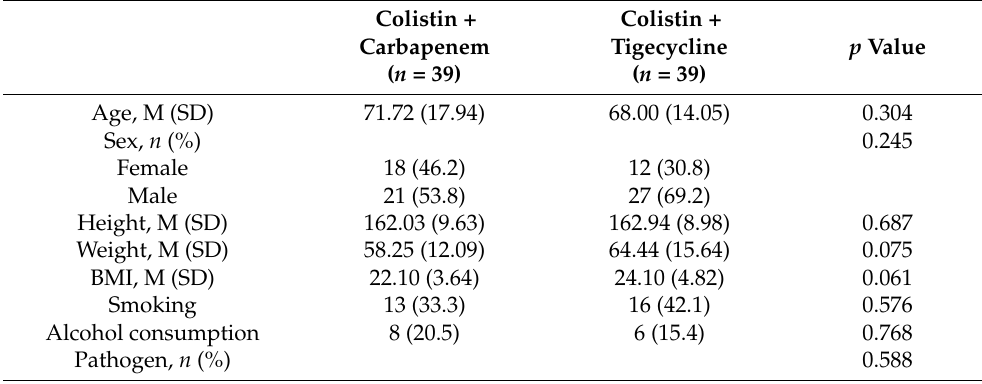
Table 2. Demographic characteristics and disease severity of ICU patients treated with colistin + carbapenem or colistin + tigecycline after propensity score